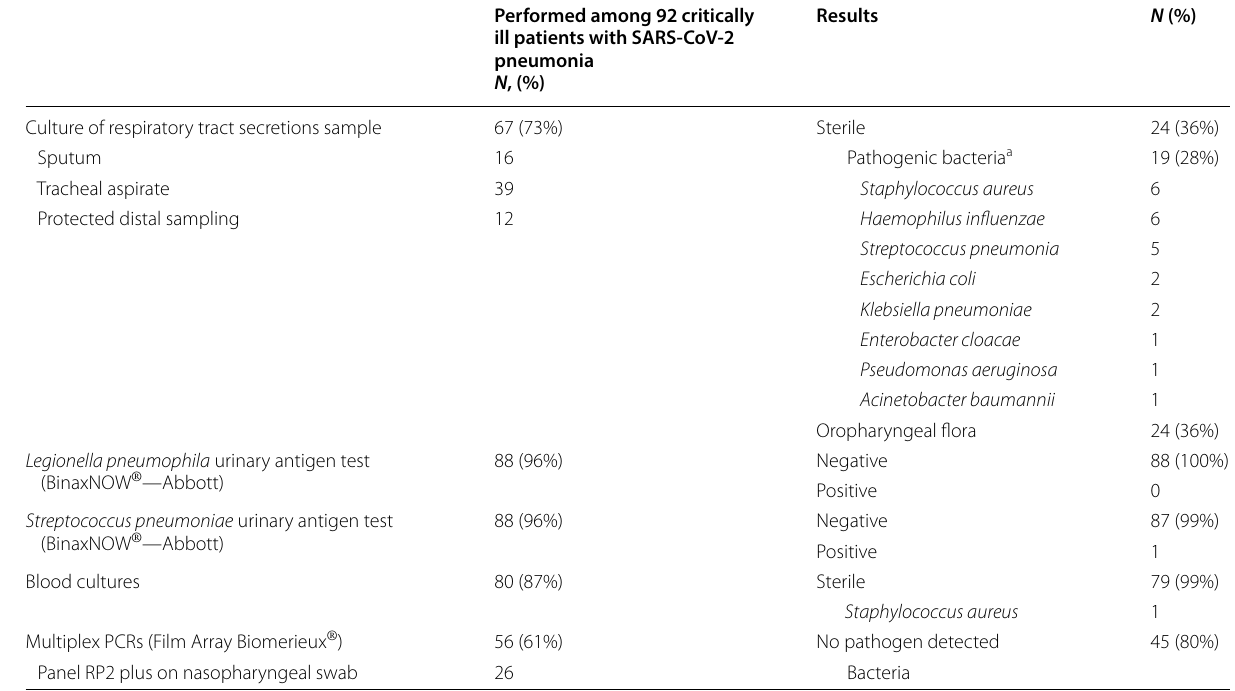
Table 2 Results of the microbiological investigations performed in 92 critically ill patients with severe SARS-CoV-2 pneumonia